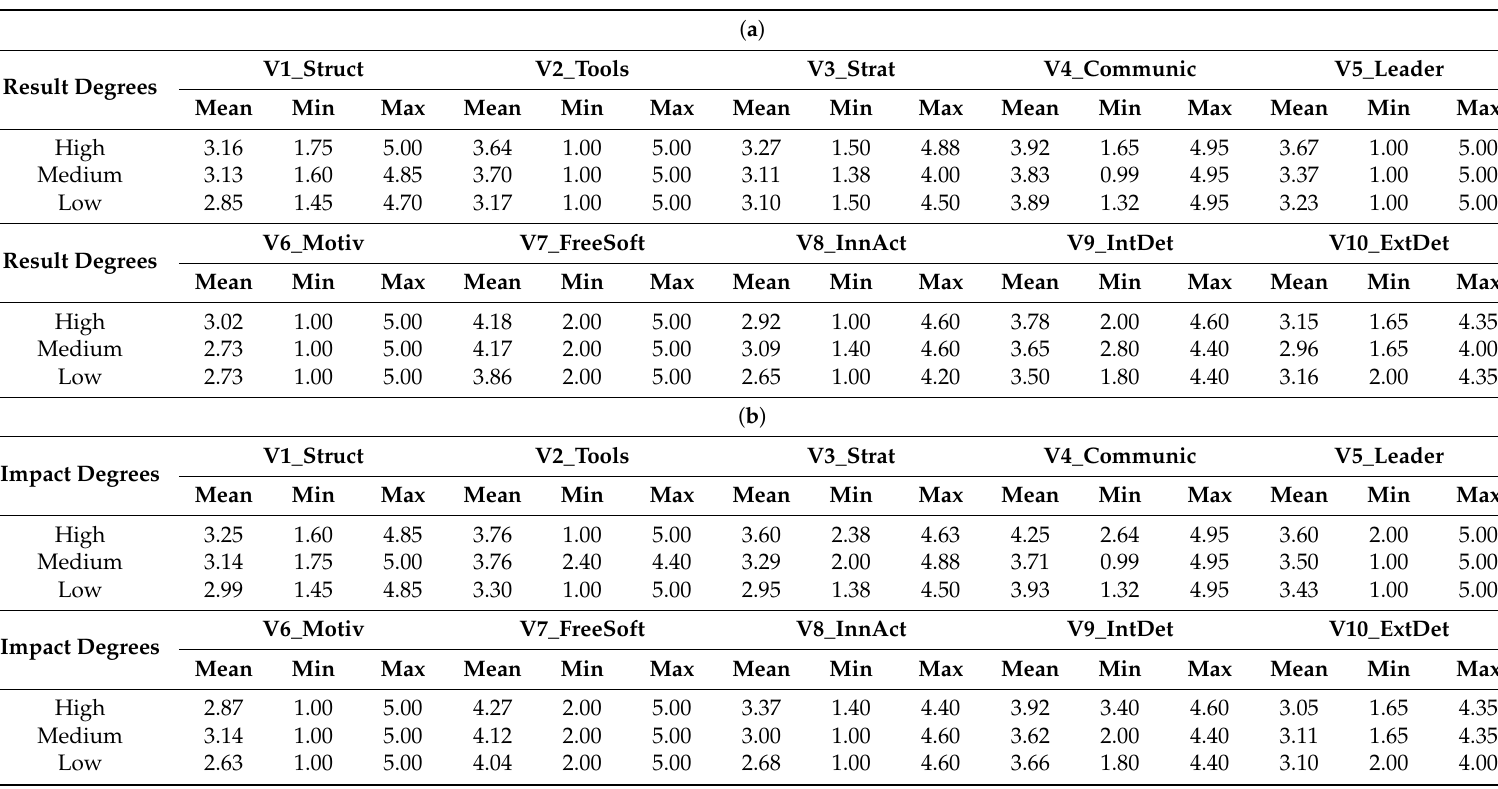
Table 7. ( a ) Summary measures (mean, minimum and maximum) by variable for each degree of Results. ( b ) Summary measures (mean, minimum and maximum) by variable for each degree of